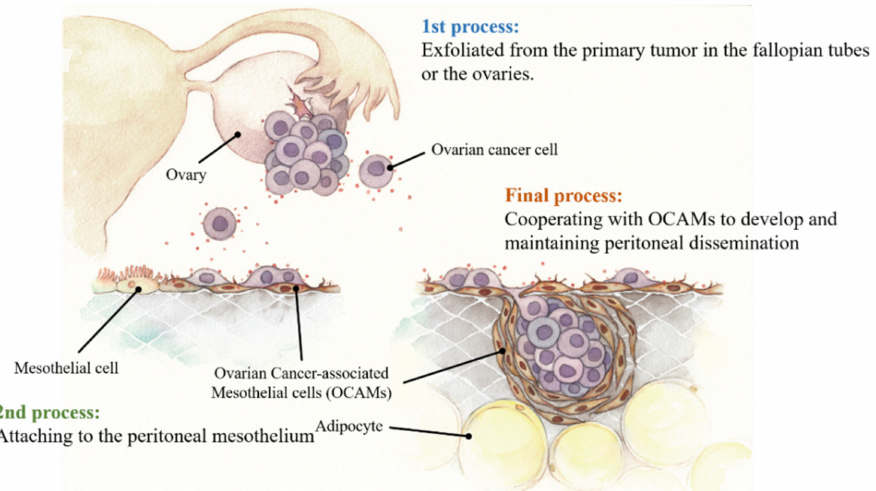
Figure 1. Three processes of development of peritoneal dissemination from ovarian cancer